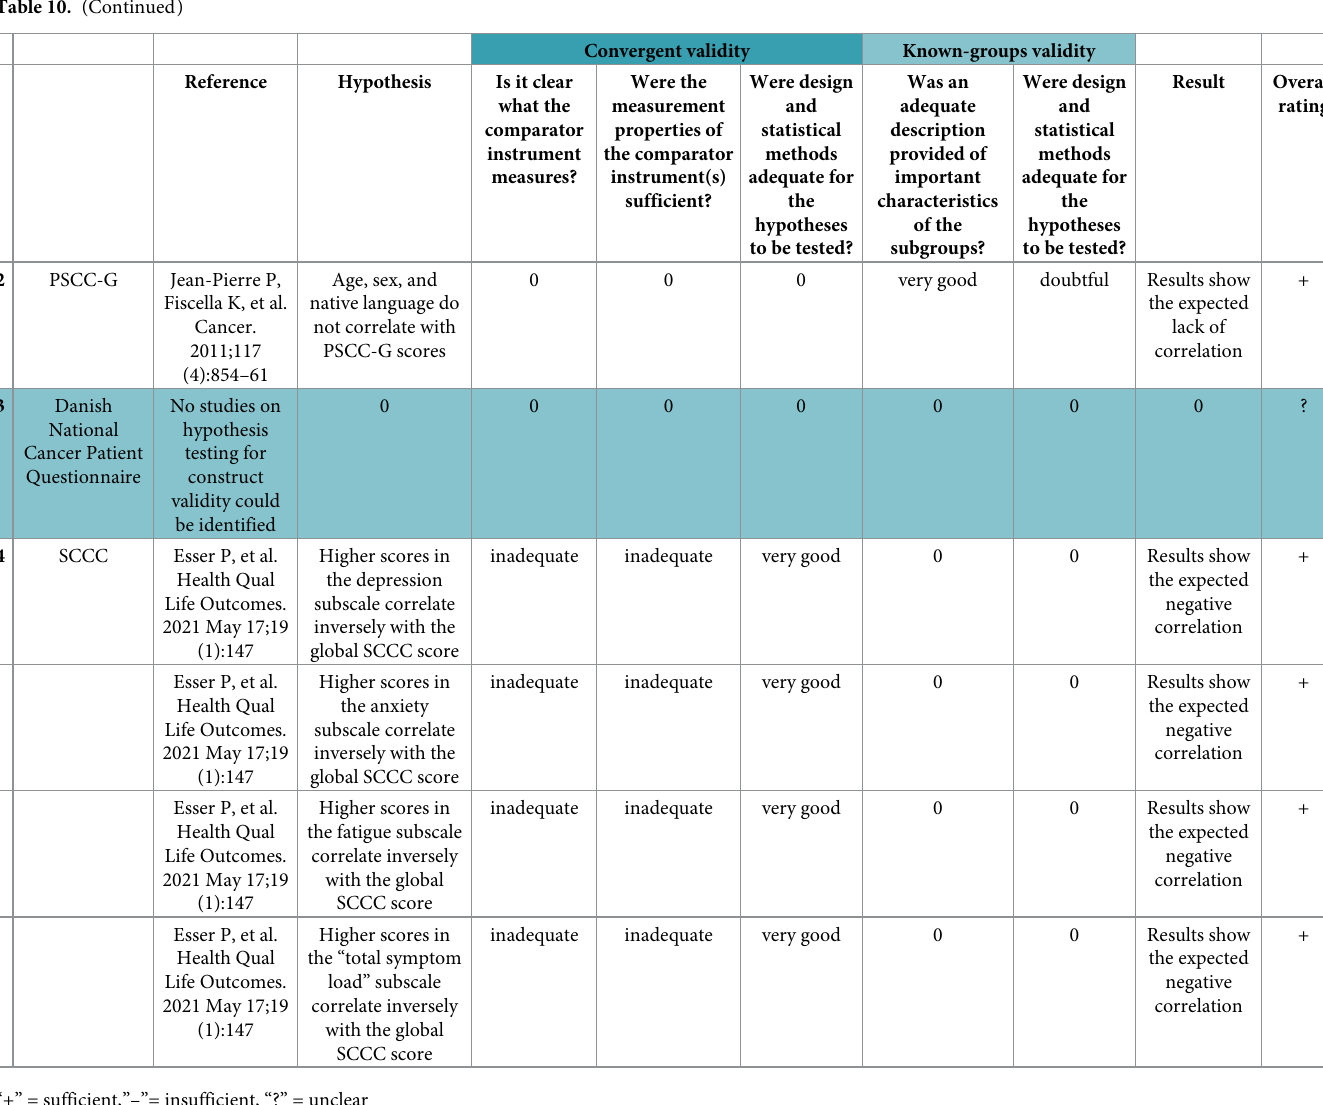
figure can facilitate preliminary PREM selection. In a next step, the results of this systematic review can be used to select a PREM with sufficient psychometric properties (Tables 5–10) and the necessary content (Tables 3 and 4). For example, for cancer care the PSCC-G has signifi- cant better psychometric properties than the SCC with its insufficient structural validity and lack of assessment in many psychometric domains. Furthermore, when selecting a PREM the intended area of application should to be considered (see introduction) [8]: is it intended as a reflection instrument for patients or rather as a provider-specific evaluation instrument for internal use or as a benchmarking instrument to compare different providers? In each case dif- ferent content dimensions (Table 3) and length of questionnaires (Table 2) are of